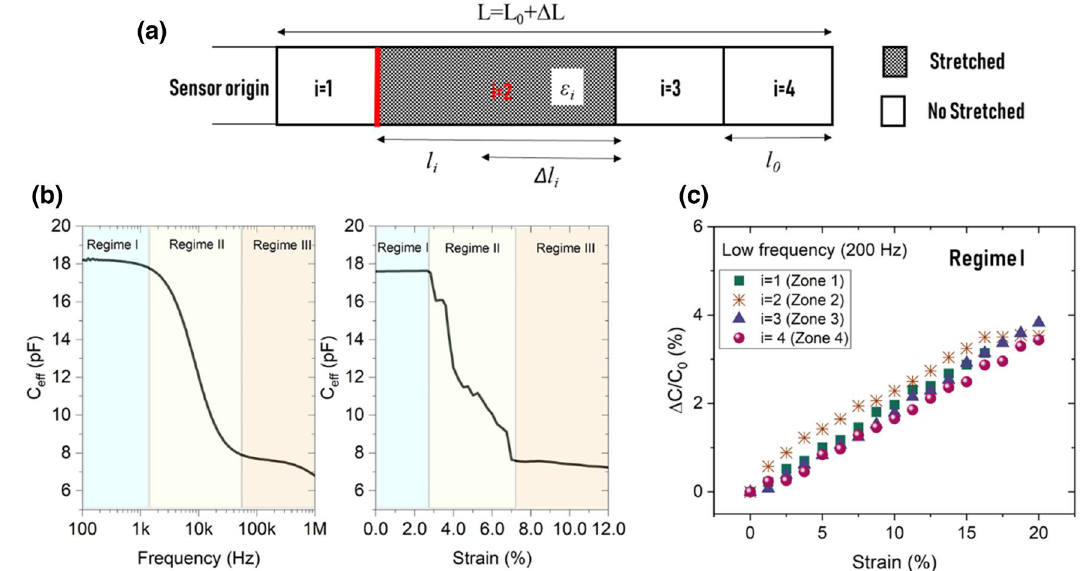
Figure 4. ( a ) schematic of a four-zones sensor with the main geometrical parameters. ( b ) Sensor capacitance versus frequency when zone 2 only is under strain (the behaviors when the other zones only are stretched are presented in Fig. S4) in the three regimes: the geometric regime at low ε and f (regime I), the transmission-line regime at intermediate ε and f (regime II), and the saturation regime at high ε and f (regime III). ( c ) Relative capacitance resulting from the geometric effect (length extension under stretching) vs. strain in regime I; this mechanism appears only at low frequency (200 Hz in this Accurate strain measurement. In this subsection, the above-identified mechanism, in which the effec- tive length changes with frequency or strain amplitude, is applied to distributed strain sensing. Multi‑information measurement capabilities. We illustrate this concept on a sensor with four identical zones L (1 ≤ i ≤ 4) and a length l i n where n represents the total number of zones into which the sensor has been = divided (Fig. 4a). Based on the result of section “Signal dissipation and virtual capacitance”, we split the capacitance variation of the sensor into three independent regimes: geometric regime (regime I), transmission-line regime (regime II), and saturation regime (regime III). These three regimes appear clearly in Fig. 4b, which plots the capacitance variation when only zone #2 ( i = 2) is under strain. Herein, the geometric regime (low f or ε ) is defined from the beginning of the measurement until the beginning of the capacitance decline. The capacitance decreases from its maximum to its minimum value within the transmission-line regime ( f = 1.5–45 kHz, ε = 2.8–8.0%). Once